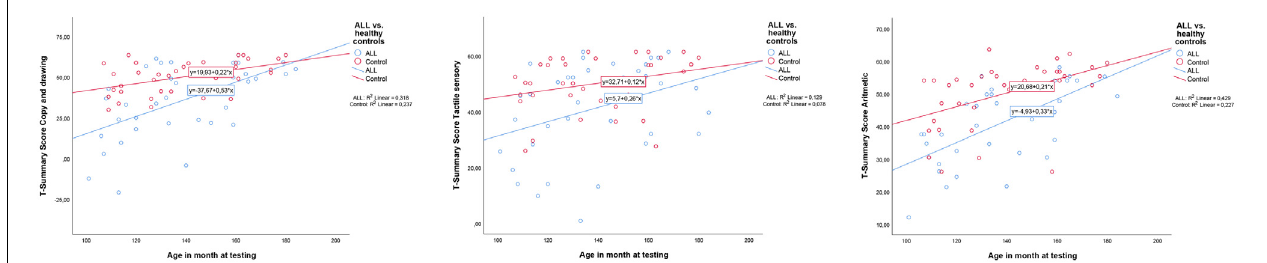
FIGURE 1 | Interactions between age and group (acute lymphoblastic leukemia or controls). From left: Copy and drawing; Arithmetic; Tactile sensory. Age is defined in months. ALL, acute lymphoblastic leukemia. As can be seen from the figures, only Copy and drawing showed a significant interaction ( F = 4.294, p = 0.042). However, the tendency went in the same direction for Arithmetic, and Sensory tactile T -scores to close the gap in neuropsychological performance between ALL patients and healthy controls with increasing